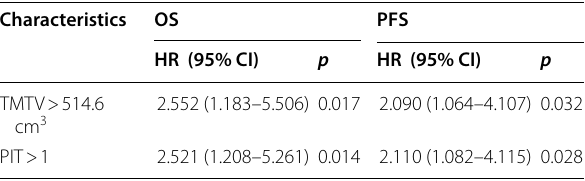
PIT was individually incorporated into multivariate analysis for reason that PIT includes four indicators which was partly incorporated into the above analysis PFS, progression-free survival; OS, overall survival; HR, hazard ratio; TMTV, total metabolic tumour volume